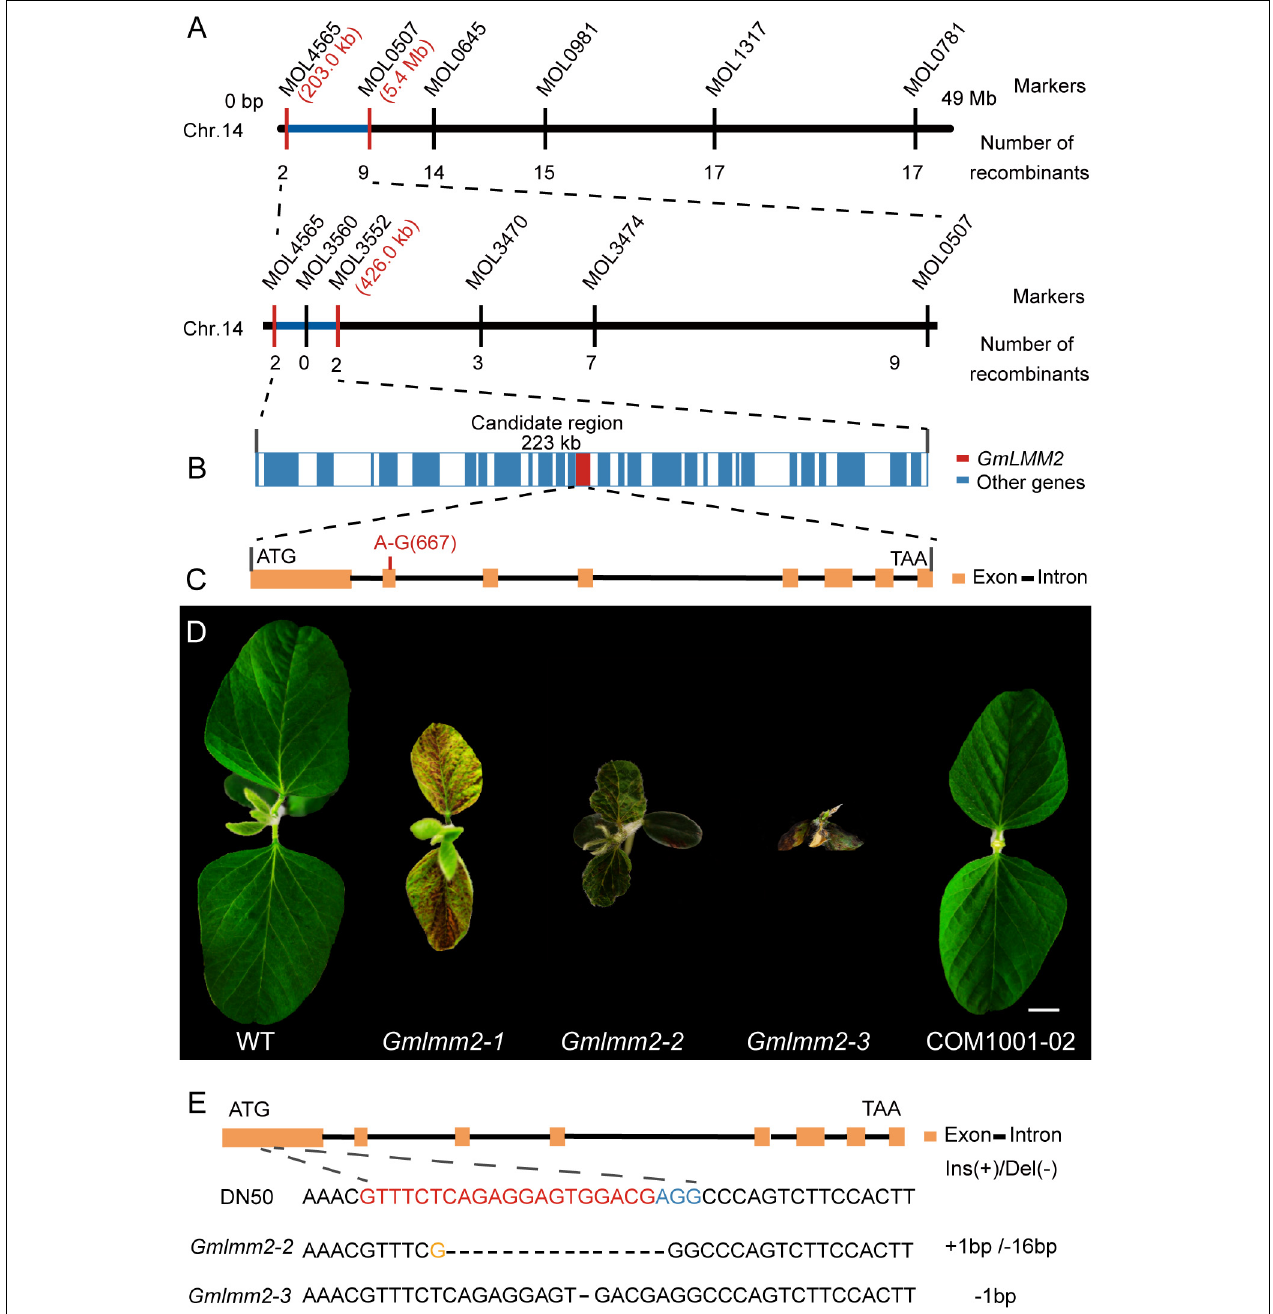
FIGURE 2 | (A) Map-based cloning of the GmLMM2 locus. The numbers under INDELs markers indicate the number of recombinants. (B) Diagram of gene distribution in 233kb region harbored GmLMM2 gene. (C) Schematic diagram shows the structure of Glyma.14G003200 . The red line denotes a A to G substitution in the second exon of GmLMM2 . (D) Phenotypes of “Williams 82,” CRISPR/Cas9 plants ( Gmlmm2-2 and Gmlmm2-3 ), complemented the Gmlmm2-1 mutant transgenic plant (COM1001-02). Scale bar = 1 cm. (E) sgRNA target sequences of “DongNong50,” Gmlmm2-2 and Gmlmm2-3 . The sgRNA target sequence is shown in red and the protospacer-adjacent motif (PAM) site in blue. The yellow colored ‘G’ indicates an insertion.